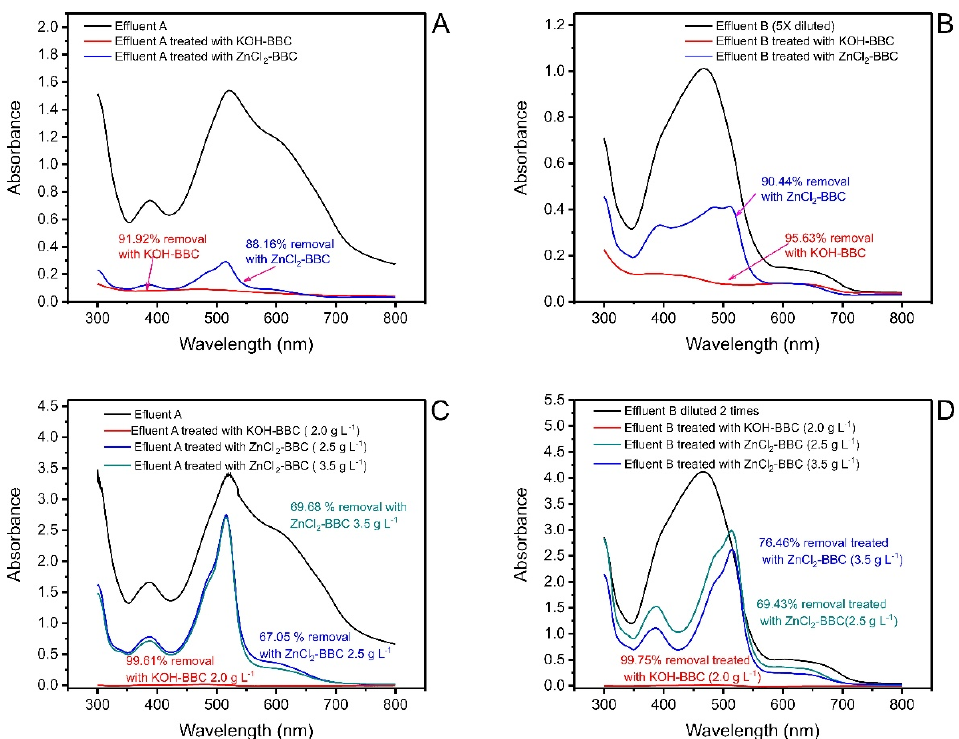
Figure 10. Adsorption of synthetic dyes effluent. ( A ) Effluent A; ( B ) Effluent B. ( C ) Effect of BBC mass dosage on effluent A treated and ( D ) effect of BBC mass dosage on effluent B treated. ZnCl 2 -BBC removed 88.2% and 90.4% for the effluent A and B, respectively, while KOH-BBC removed 91.9% and 95.6% at an adsorbent dosage of 1.5 g L − 1 (Figure 10A and